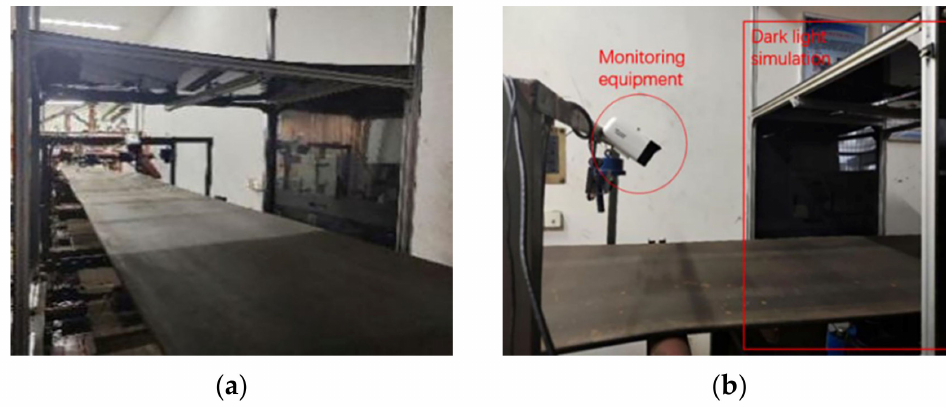
Figure 6. Layout of belt conveyor and other devices in the laboratory. ( a ) Laboratory belt conveyor. ( b ) Camera arrangement.